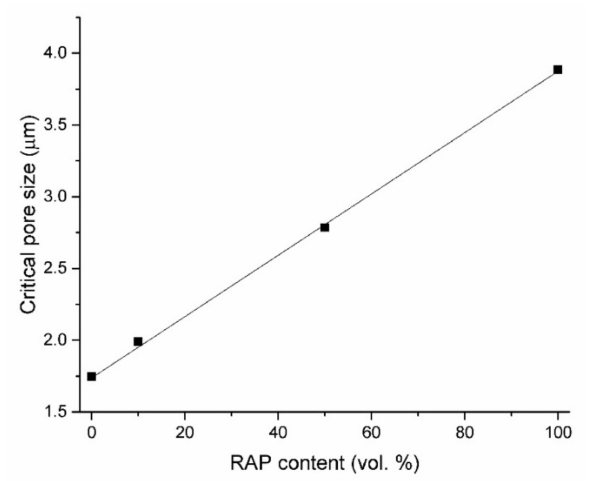
Figure 7. Cumulative pore volume curves obtained for reference (RC) and RAP (RA-C 10, RA-C 50, RA-C 100) specimens.